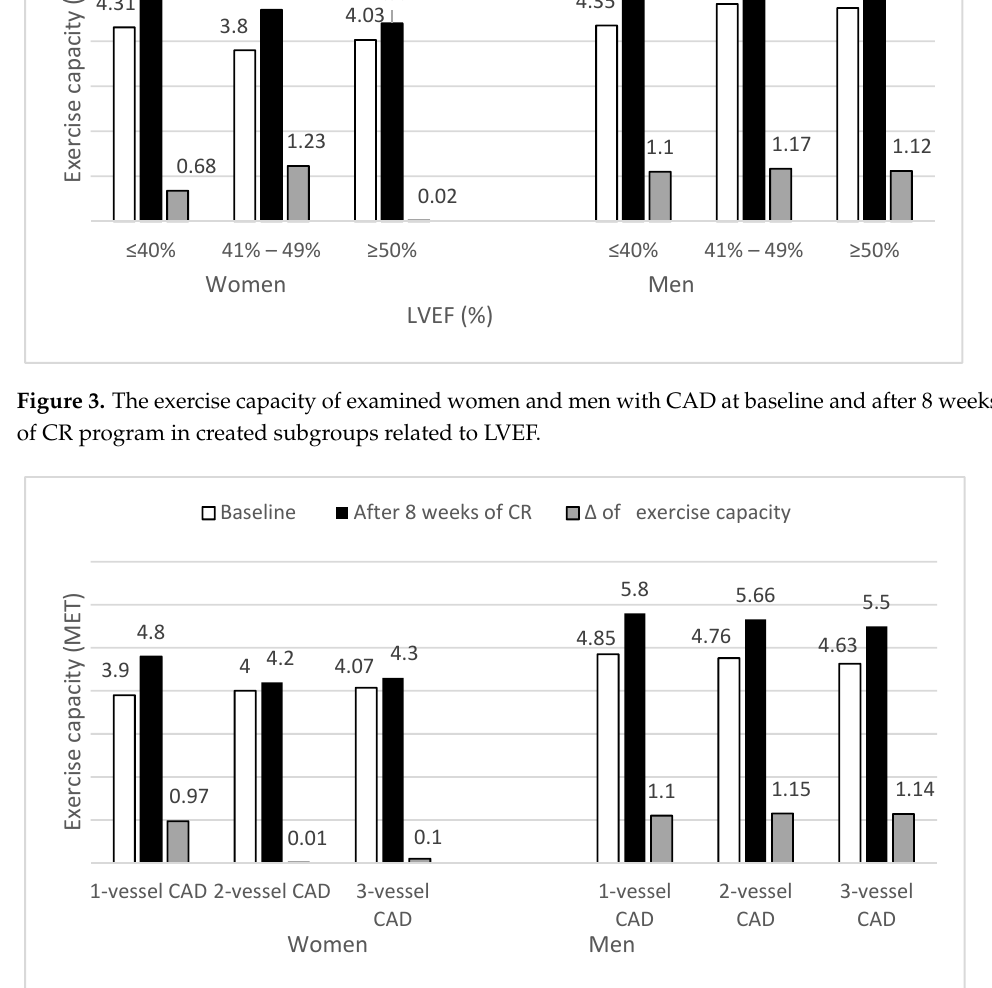
Figure 3. The exercise capacity of examined women and men with CAD at baseline and after 8 weeks of CR program in created subgroups related to LVEF.